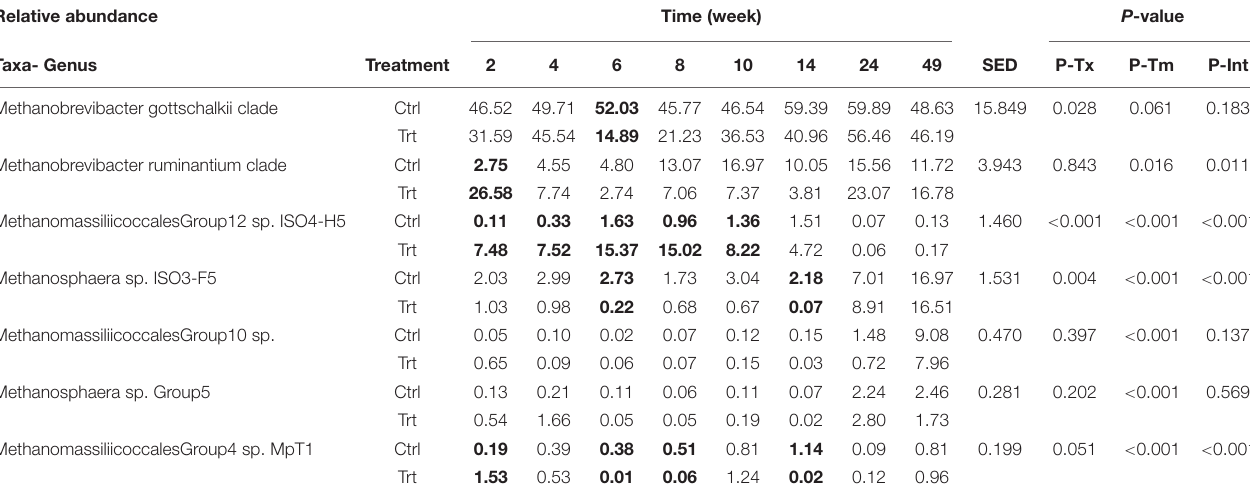
TABLE 7 | Effect of methane inhibitors 1 on the relative abundance of archaeal species (%) 2 at different sampling times 3 . Relative abundance Time (week) P -value Taxa- Genus